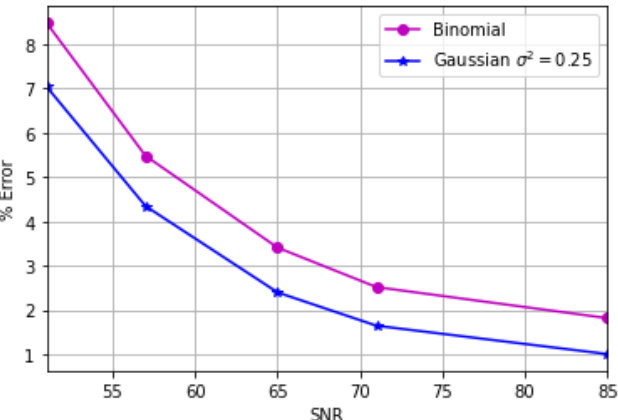
Figure 10. Graph of % error for an image with added Gaussian source noise for a single-lensed microlensing event with µ 0 = 0.01. Binomial and Gaussian measurement matrices, with the given variance, are used for comparison.